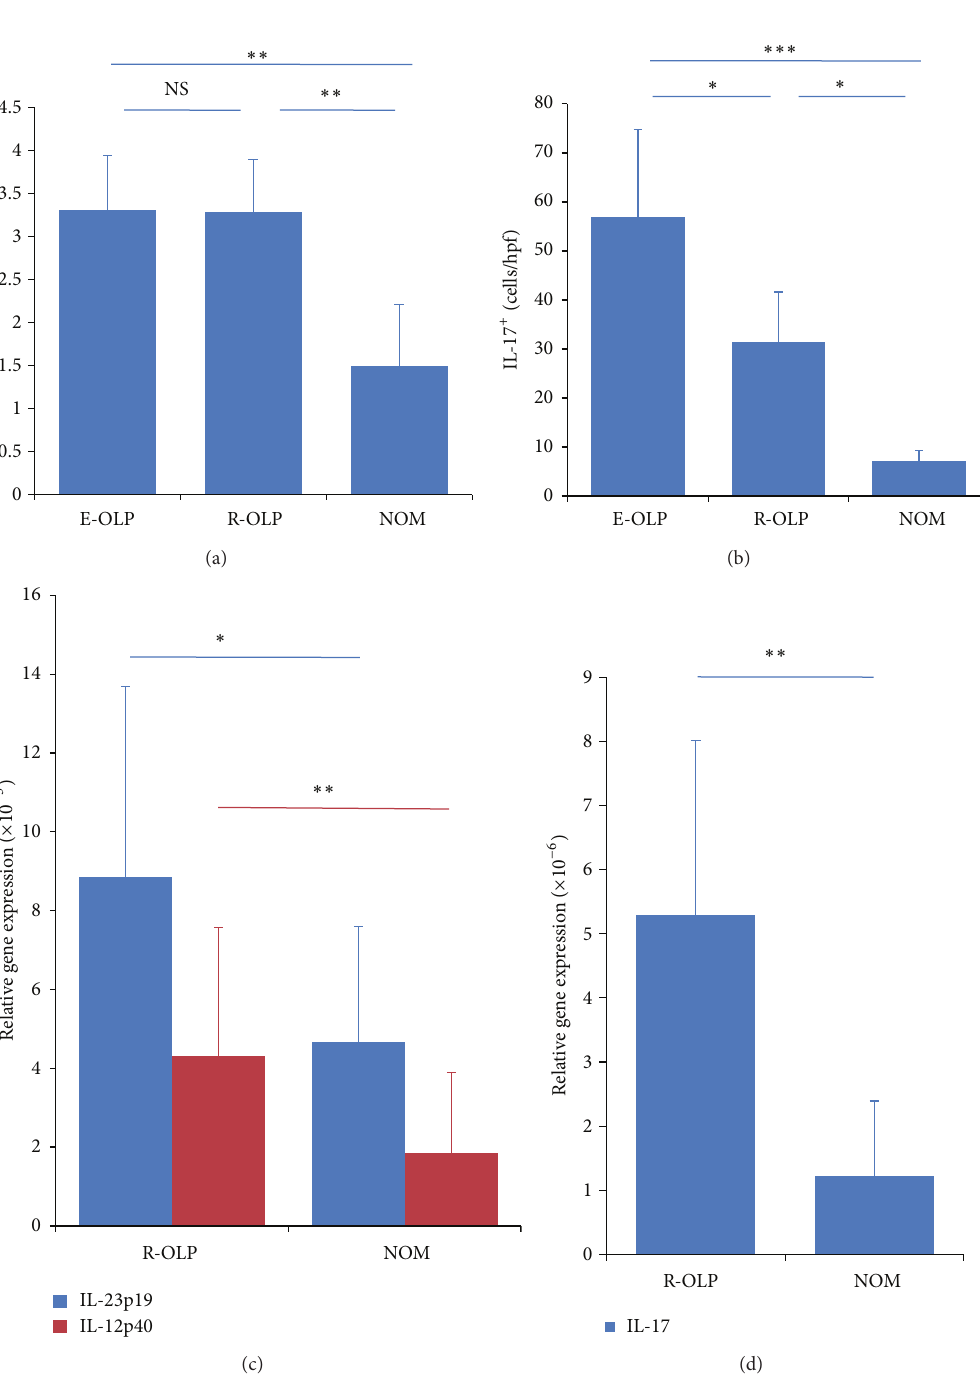
Figure 2: Expressions of IL-23 and IL-17 in OLP lesions. (a) The average staining scores of IL-23p19 in erosive OLP lesions ( 𝑛 = 13 ), reticular OLP lesions ( 𝑛 = 14 ), and normal oral mucosa tissues ( 𝑛 = 10 ). (b) The average number of IL-17+ cells per hpf in erosive OLP lesions ( 𝑛 = 13 ), reticular OLP lesions ( 𝑛 = 14 ), and normal oral mucosa tissues ( 𝑛 = 10 ). ((c) and (d)) The mRNA expressions of IL-23p19, IL-12p40, and IL-17 in reticular OLP lesions ( 𝑛 = 14 ) and normal oral mucosa tissues ( 𝑛 = 10 ). All data were shown as mean ± SEM. ∗∗ 𝑃 < 0.01 ; ∗∗ 𝑃 < 0.05 ; NS: